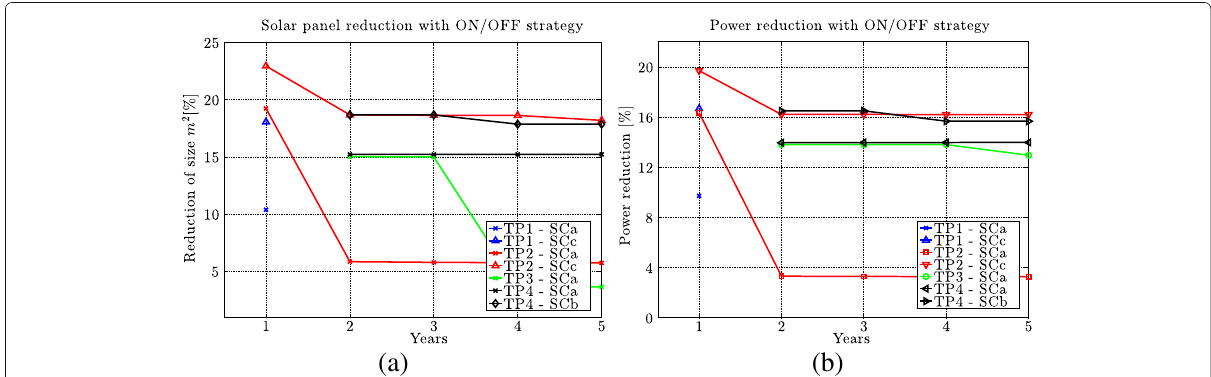
Fig. 9 Cost and energy savings for different traffic profiles and different types of carriers within the first 5 years. a Solar panel reduction size. b Power consumption reduction